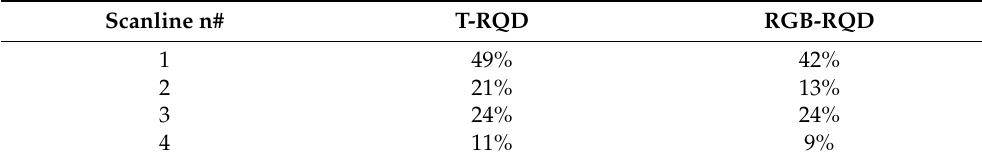
Table 4. Comparison between T-RQD and RGB-RQD data. The scanline n# refers to Figure 7d. Scanline